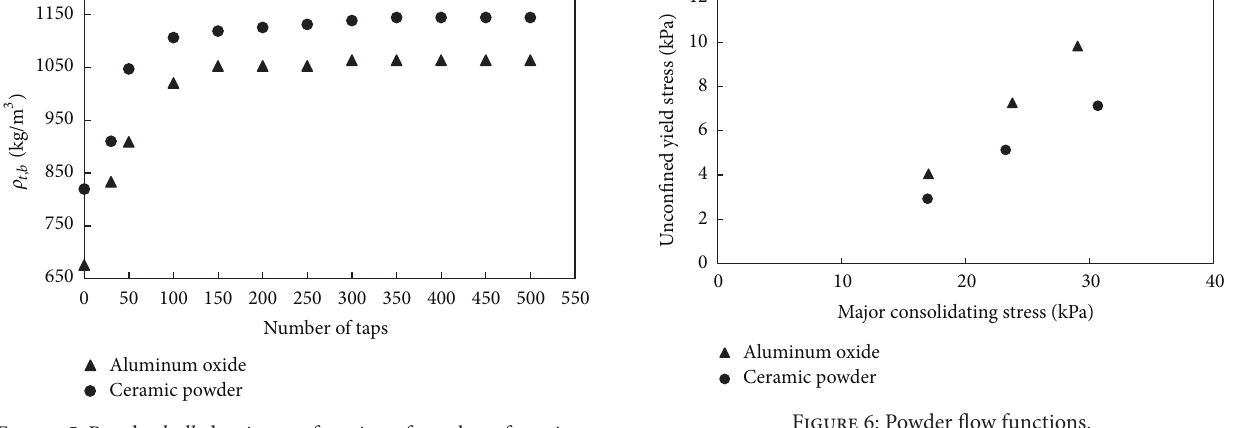
Figure 5: Powder bulk density as a function of number of tappings.